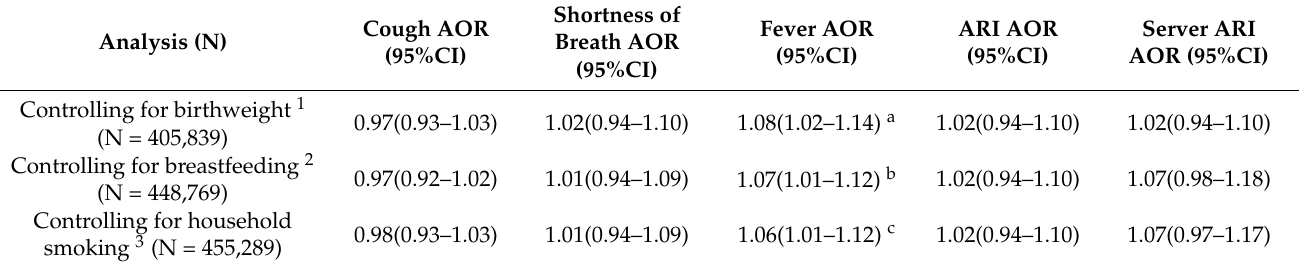
Table A2. Summary effects (AOR–95% CI) for respiratory symptoms, ARI and severe ARI with wood cooking for the exploratory